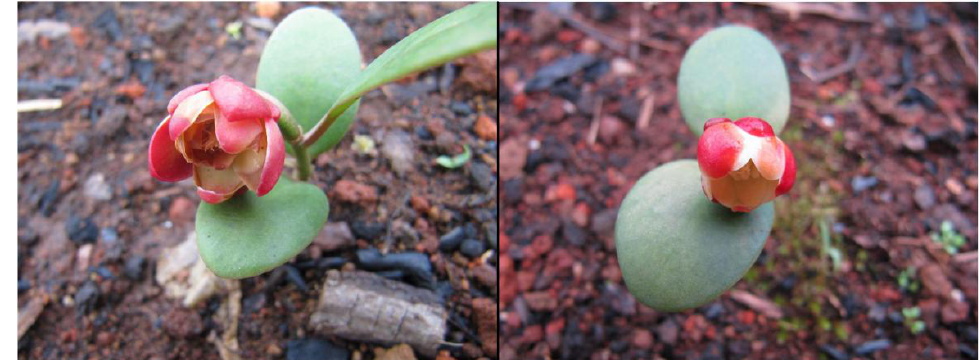
Figure 1. Flowering of I. difengpi (Illiciaceae) at cotyledon stage in natural habitat (Adapted with permission from ref. [3]. Copyright 2021 Elsevier).